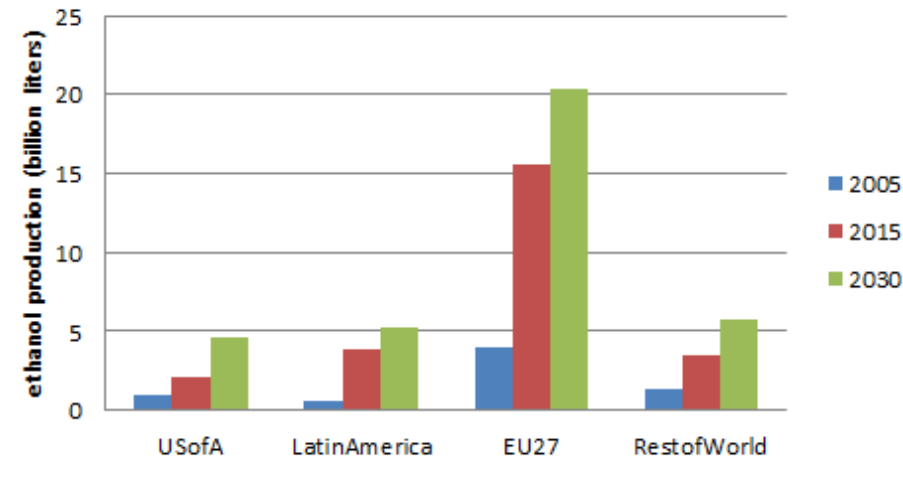
Figure 10. Biodiesel production in major regions under